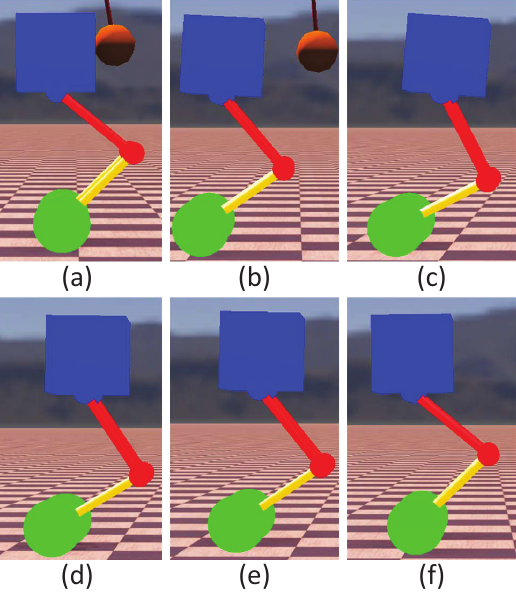
Figure 7. Snapshots of the simulation for the impact recovery. Photos ( a – c ) show that the robot maintains its balance by changing its state during the initial stage of being impacted. Photos ( d – f ) show the process of the robot gradually returning to the reference state.